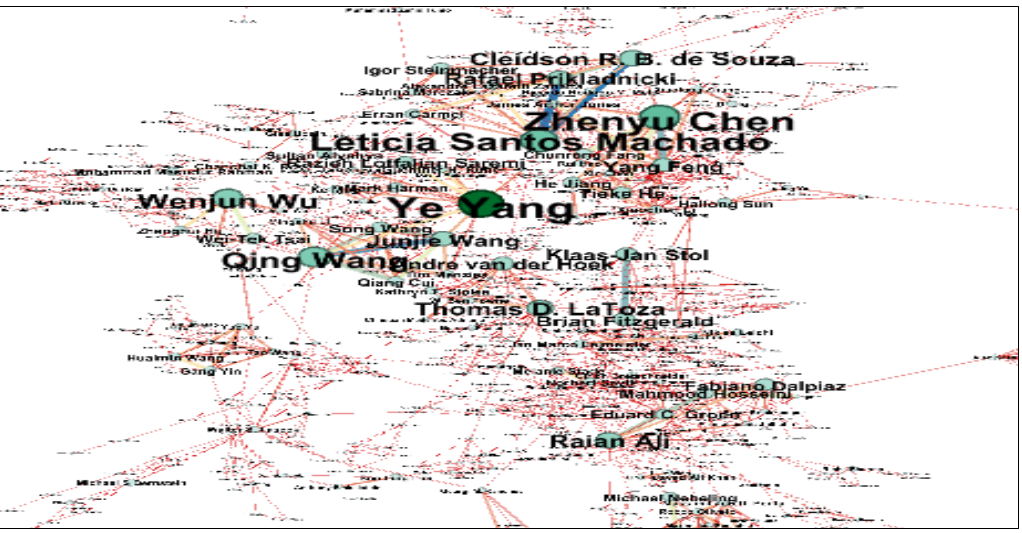
Figure 3. Co-authorship network, https://github.com/Aalabduljabbar/CSE-Publications (accessed on 1 February 2022).